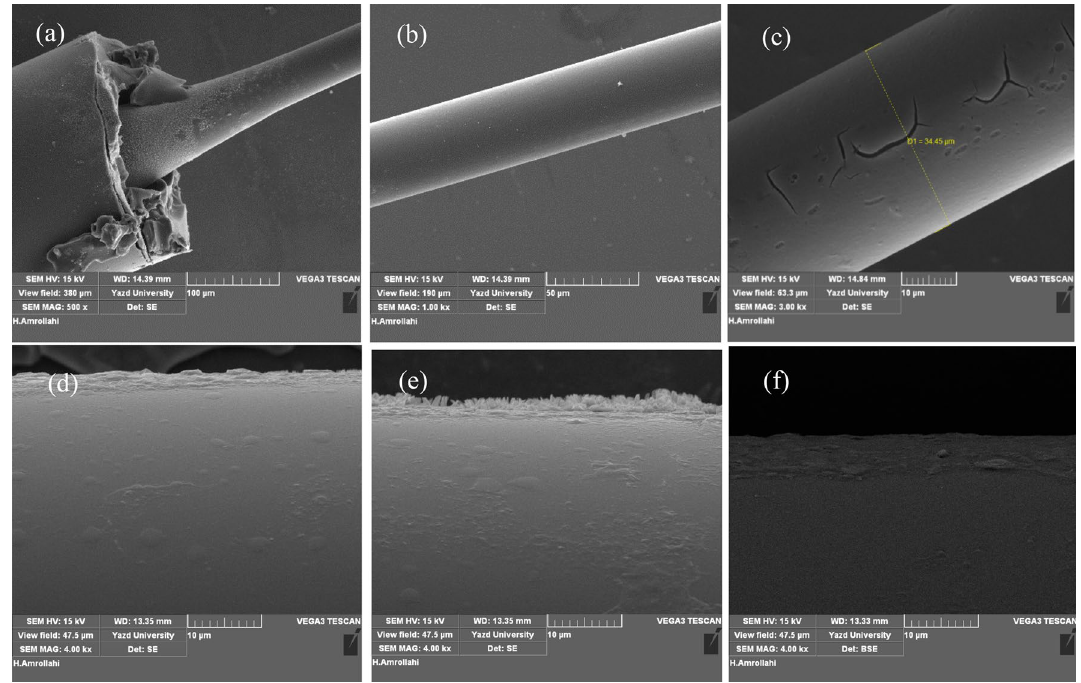
Figure 4. The SEM images of ESMF (a–c) and G/GO coated ESMF (d) , MoSe 2 coated ESMF (e) , MoS 2 coated ESMF (f) .